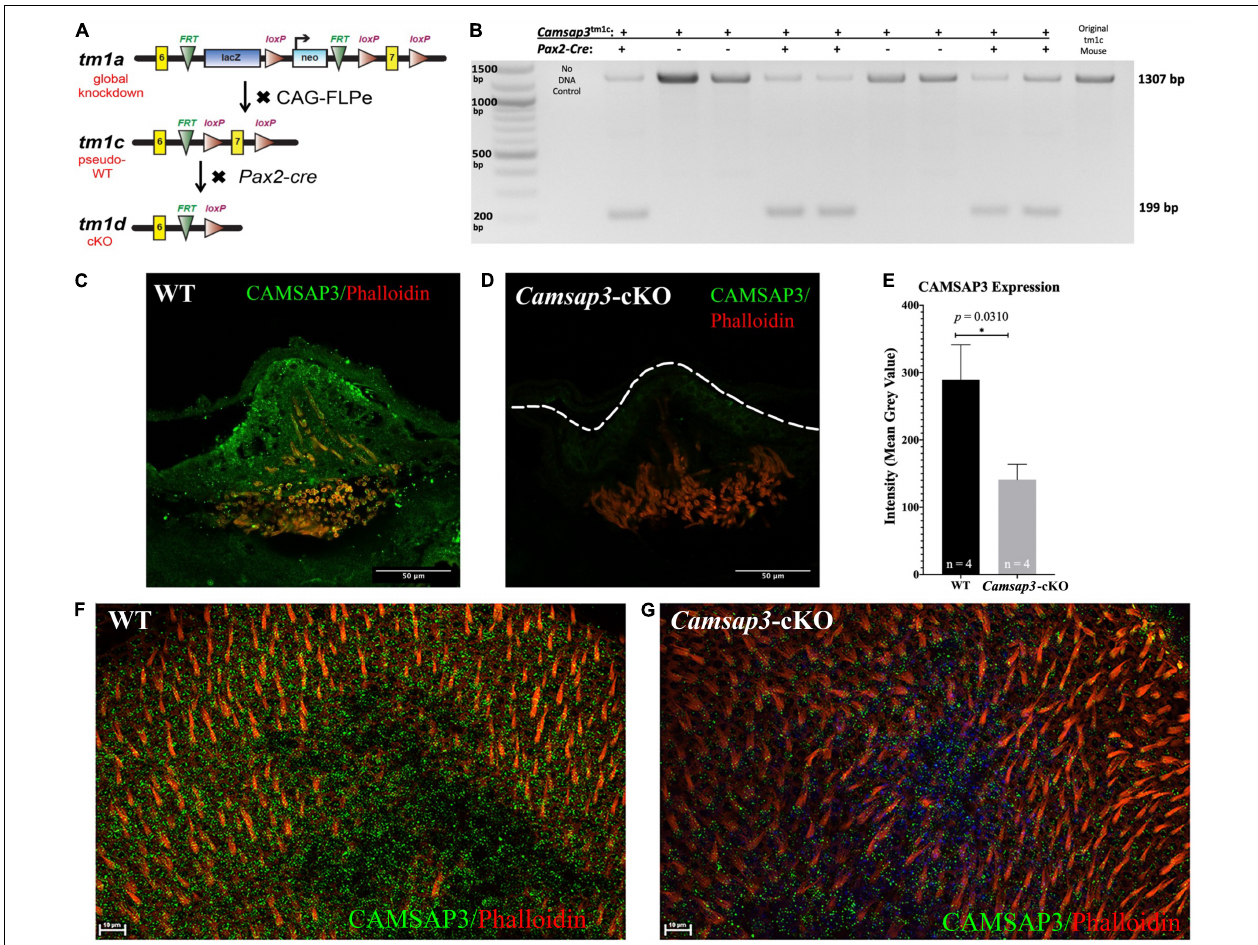
FIGURE 1 | Creation and validation of the Camsap3- cKO mouse. (A) A schematic diagram of the Camsap3 knockout first targeting strategy and conversion of tm1a (KO first) to tm1c (floxed), and tm1d (cKO) alleles, respectively. Tg Pax2 Cre / + ; Camsap3 tm 1 c / tm 1 c mice, known as Camsap3 -cKO, are a cKO model for the vestibular organ. (B) The exon 7 of Camsap3 execution was validated by PCR genotyping. The inner ear genomic DNA of offspring derived from crossing Tg Pax2 Cre and Camsap3 tm 1 c / tm 1 c were isolated and used for PCR ( n = 9 from two separate litters). No DNA and floxed allele Camsap3 tm 1 c / tm 1 c were used as the negative and positive controls. The bands were expected to be 1307 bp for WT (Tg Pax2 Cre + / + ; Camsap3 tm 1 c / tm 1 c ) and 199 bp for Camsap3 -cKO mice. (C–G) CAMSAP3 protein expression in the vestibular system as examined by immunofluorescence. (C,D) Representative immunofluorescent images of a crista from WT (C) and Camsap3 -cKO (D) mouse at P75 were shown. The dashed line outlines the edge of the crista of a Camsap3 -cKO mouse. Scale Bars = 50 µ m. (E) Vestibular cells from Camsap3 -cKO mice had significantly less CAMSAP3 staining than their WT counterparts. The bars represent mean ± SD. *Statistically significant difference ( p = 0.03). WT and Camsap3 -cKO mice littermate (P75) replicates (n) were as indicated. (F,G) Representative confocal maximum projection of z-stack images taken from whole-mounts utricle samples of a WT (F) and a Camsap3 -cKO mouse (G) . More CAMSAP3 staining dots were found on the apical surface of WT utricle compared to those on Camsap3 -cKO mouse. Scale Bars = 10 µ m. Antibodies: anti-Camsap3 (Green), phalloidin